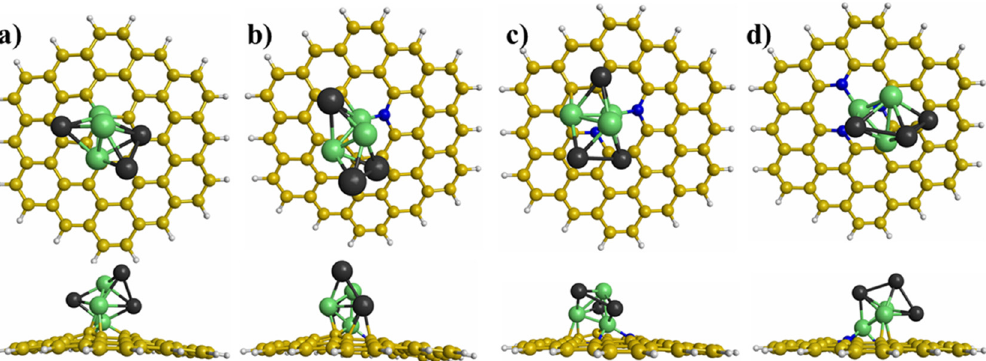
Figure 5. Top and side views of the most stable adsorption sites of the Ni 3 Pd 3 cluster supported on graphene with different defects: ( a ) graphene with a vacancy, ( b ) pyridinic N-doped graphene (PNG) with one N atom, ( c ) PNG with two N atoms, and ( d ) PNG with three N atoms.